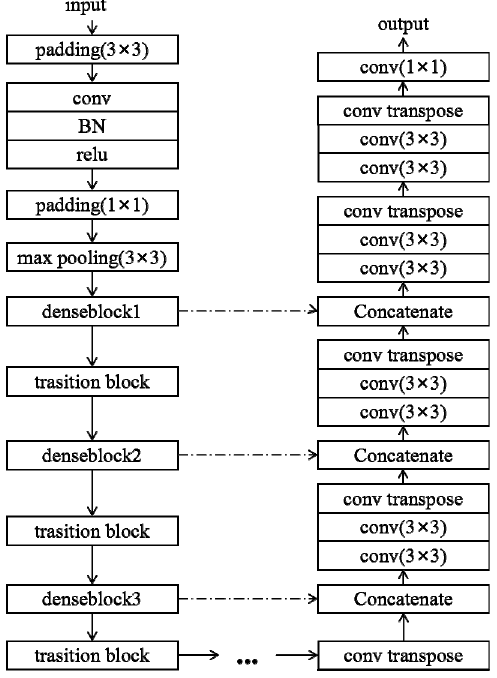
Figure 3. Proposed network architecture for semantic identification based on the DenseNet model.